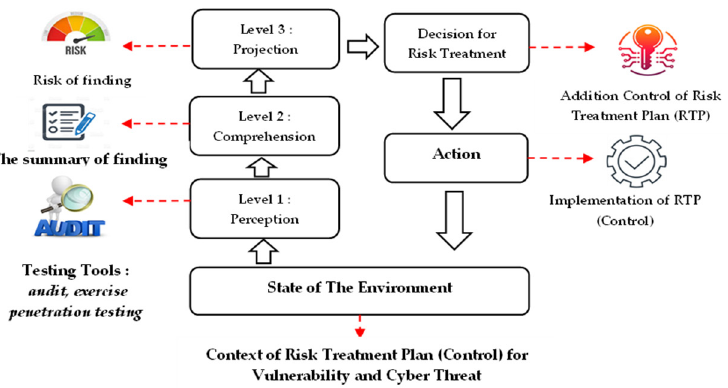
Figure 5. New Model of The Risk Treatment Plan Testing Framework with The Situational Awareness Model (Novelty).